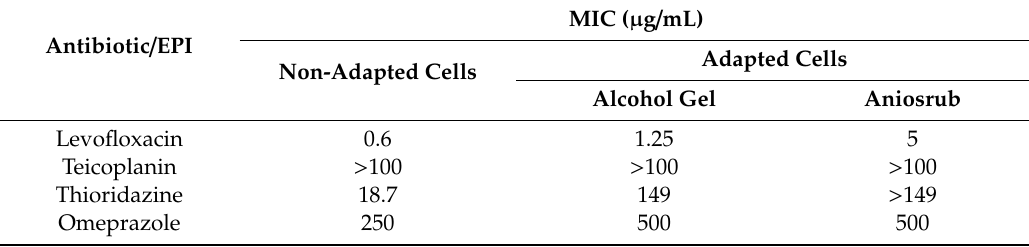
Table 1. Minimum inhibitory concentrations (MIC) of the antibiotics levofloxacin and teicoplanin, and of the e ffl ux pump inhibitors thioridazine and omeprazole, toward M. vaccae cells not adapted and adapted to the disinfectants alcohol gel and